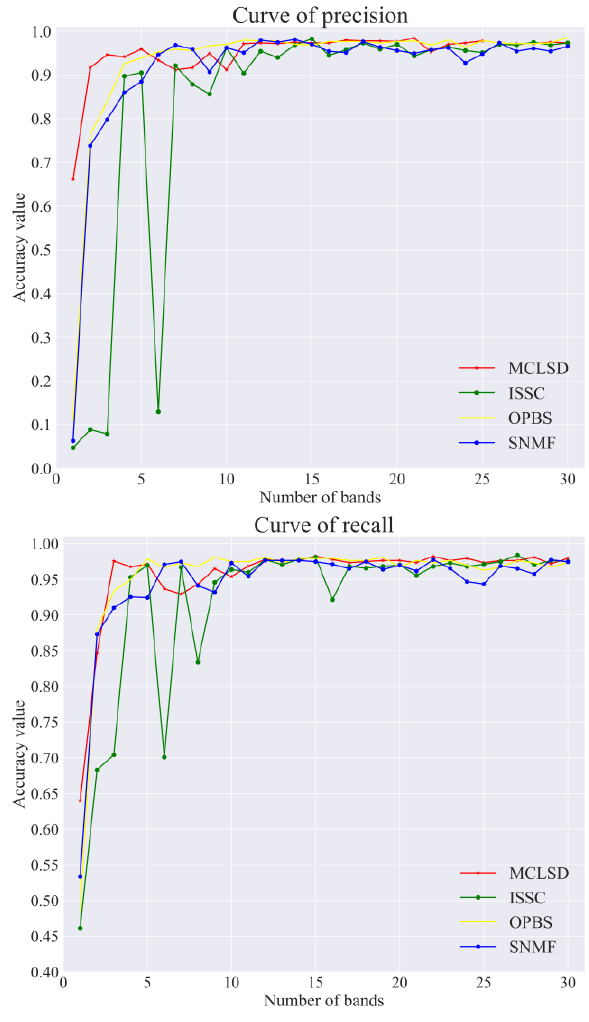
Figure 6. The classification accuracy of the compared BS methods under different number of bands.